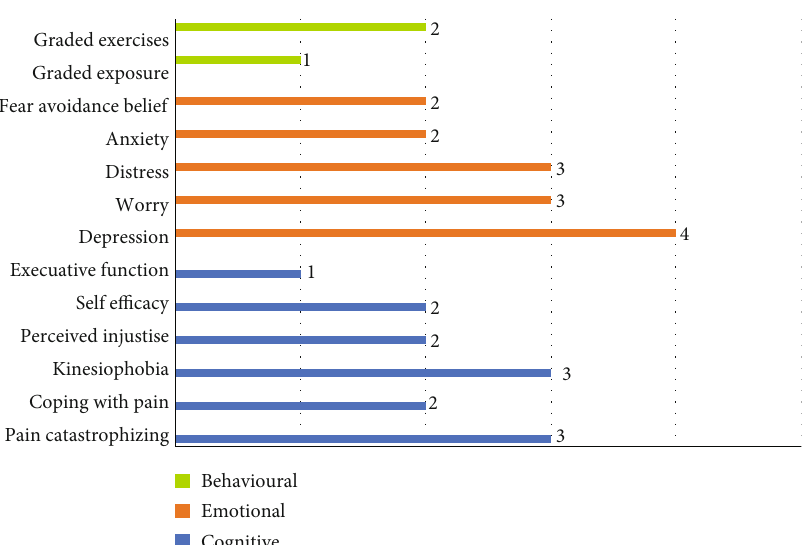
Figure 2: Frequency of the extracted construct from the included